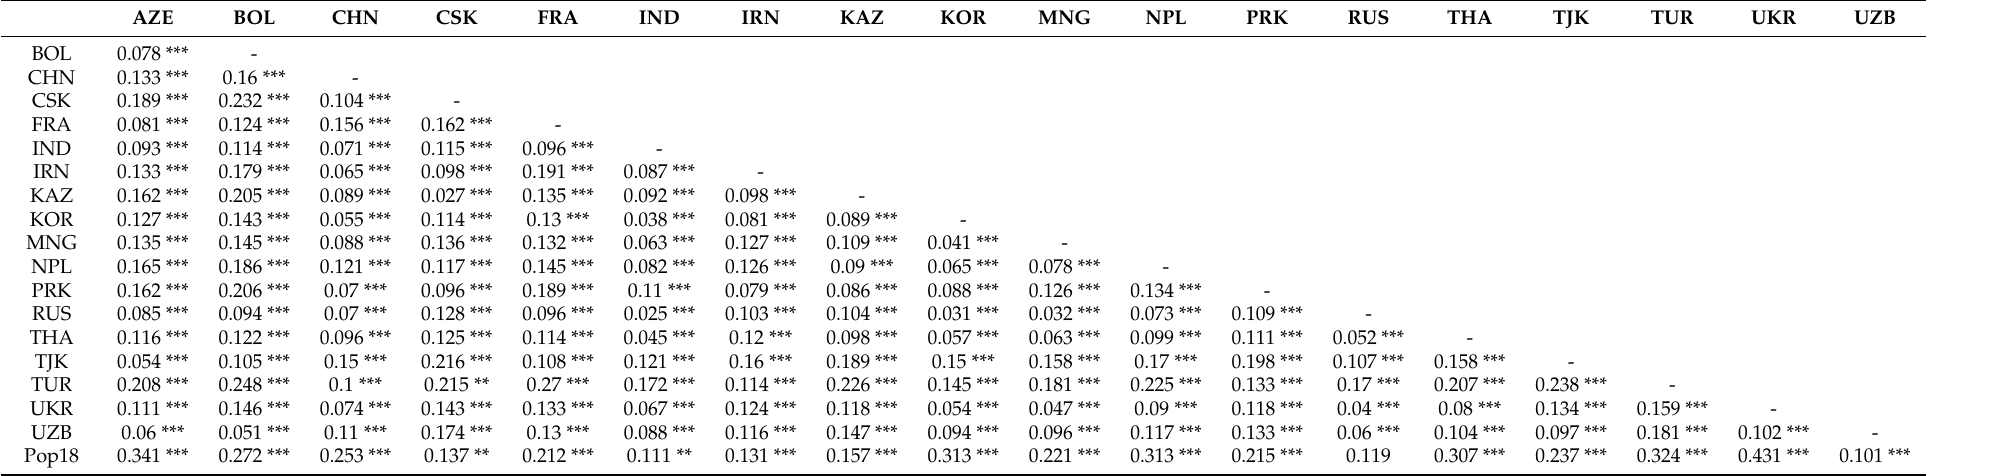
Table 3. Differentiation among origin populations according to the fixation index